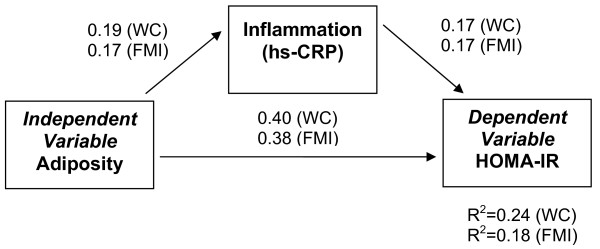
Pathways between two measures of adiposity--WC (Model 1)† and FMI (Model 2)‡--and HOMA-IR: standardized path coefficients. † Model 1: WC controlling for sex (β = 0.01) and tanner stage (β = -0.96) Bentler's CFI = 1.00; RMSEA = 0.00. ‡ Model 2: FMI controlling for sex (β = 0.11) and tanner stage (β = -0.41) Bentler's CFI = 0.99; RMSEA = 0.07. All pathways are statistically significant at t > 1.96.